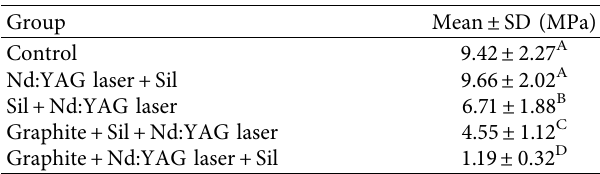
Table 1: Tensile bond strength (mean ± SD) in megapascals (MPa) of the five experimental groups. Different uppercase letters indicate a significant statistical